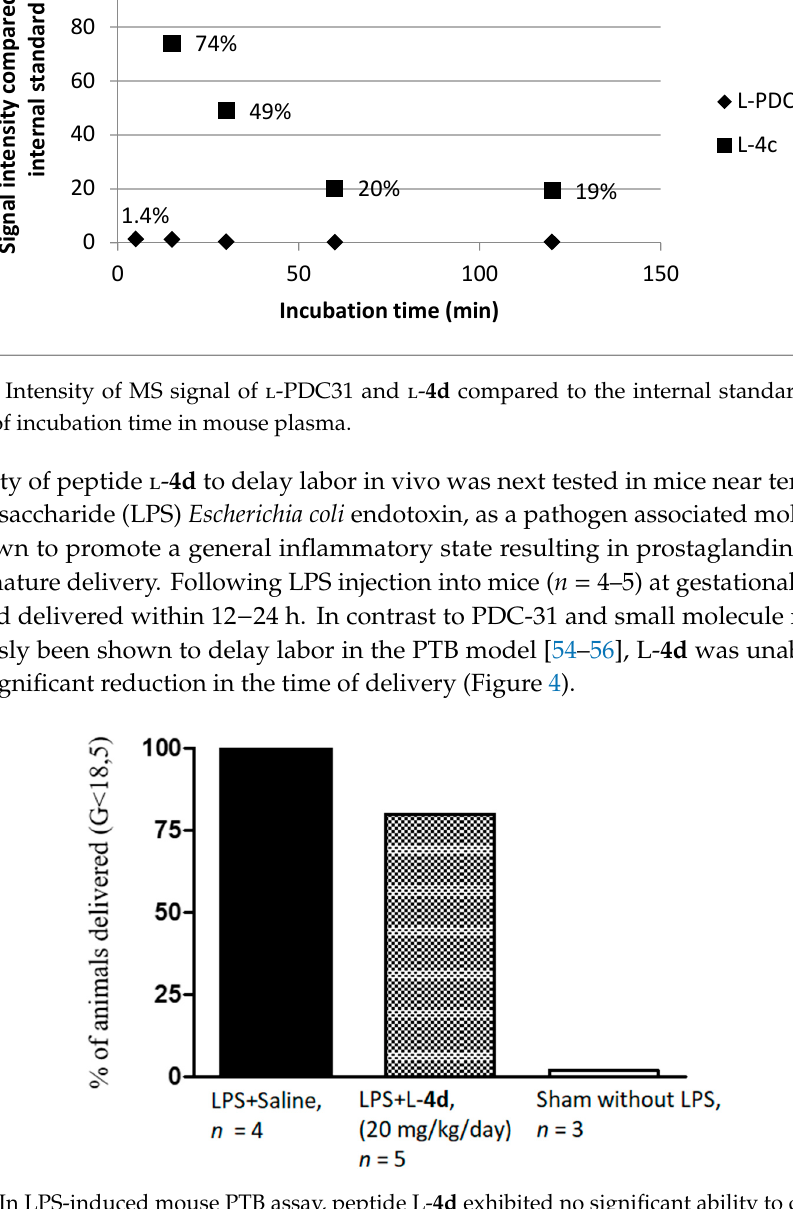
Figure 4. In LPS ‐ induced mouse PTB assay, peptide L ‐ 4d exhibited no significant ability to delay labor.